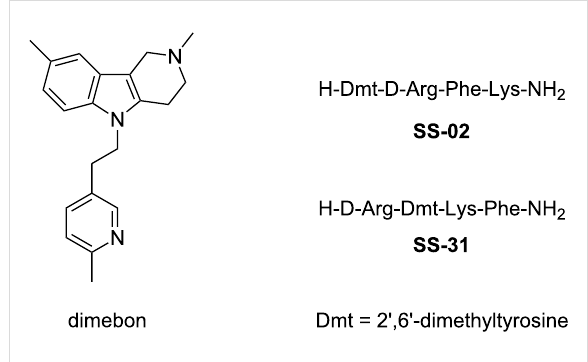
Figure 1: Structures of dimebon and SS